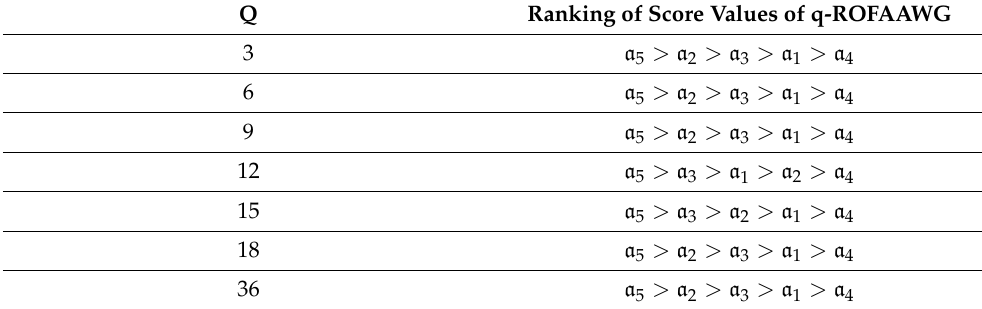
Table 9. Ranking of score values by changing q.